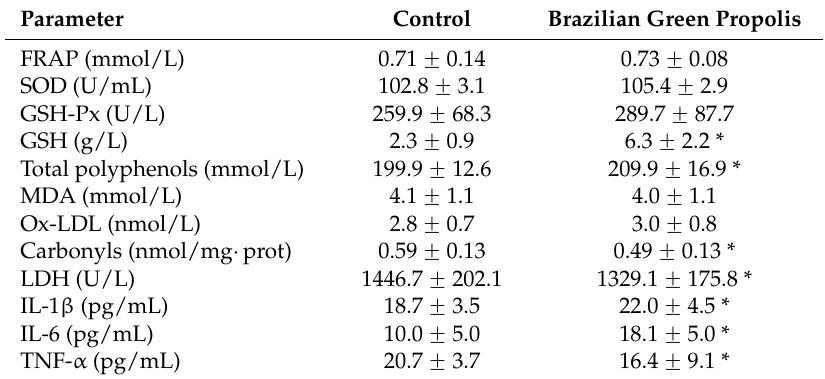
Table 4. Effects of Brazilian green propolis on antioxidant function and cytokines in T2DM